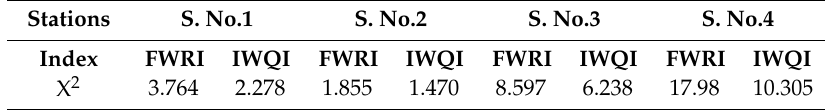
Table 10. The X 2 -test comparing the FWRI and IWQI values with the o ffi cial classification at the four stations over the period from September 2013 to August